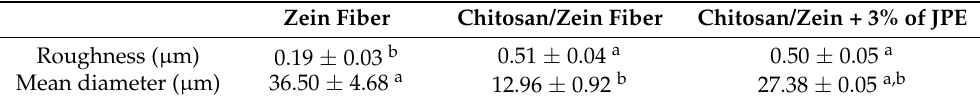
Mean ± mean deviation (n = 2 for roughness, n = 6 for mean diameter). Different letters in the same column indicate significant differences between the samples for the t -test ( p < 0.05).